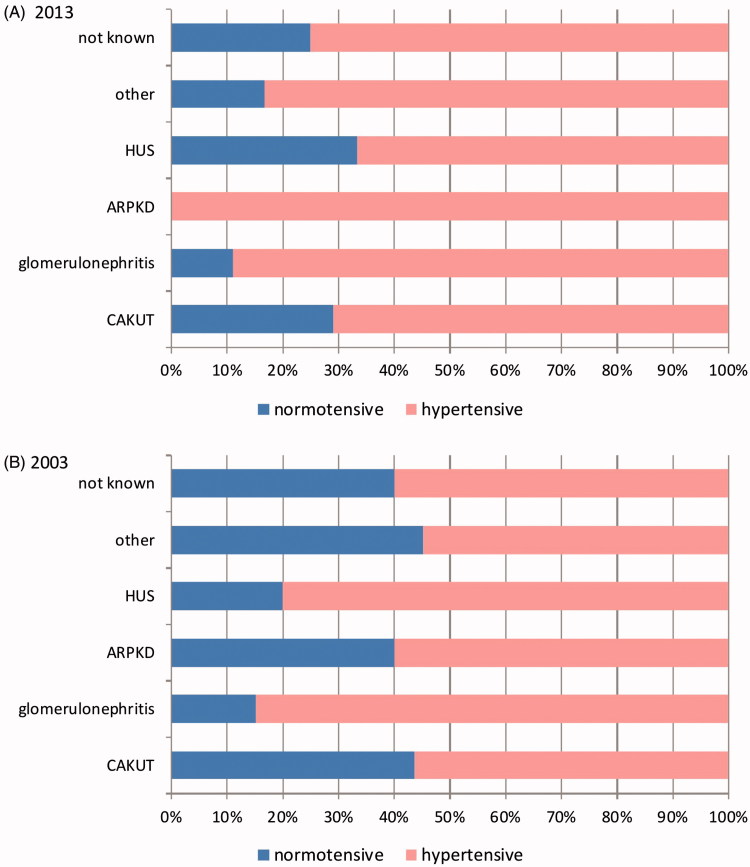
Proportion of hypertensive to normotensive patients in the study group according to the diagnosis of CKD.